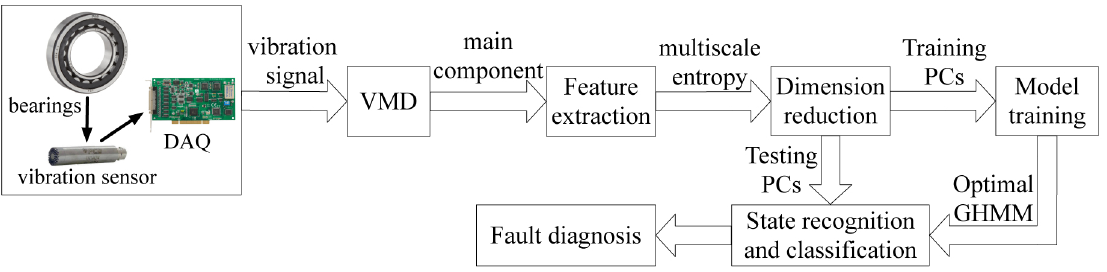
Figure 1. Basic flow of the proposed hybrid generalized hidden Markov model-based condition monitoring (GHMM-CM)